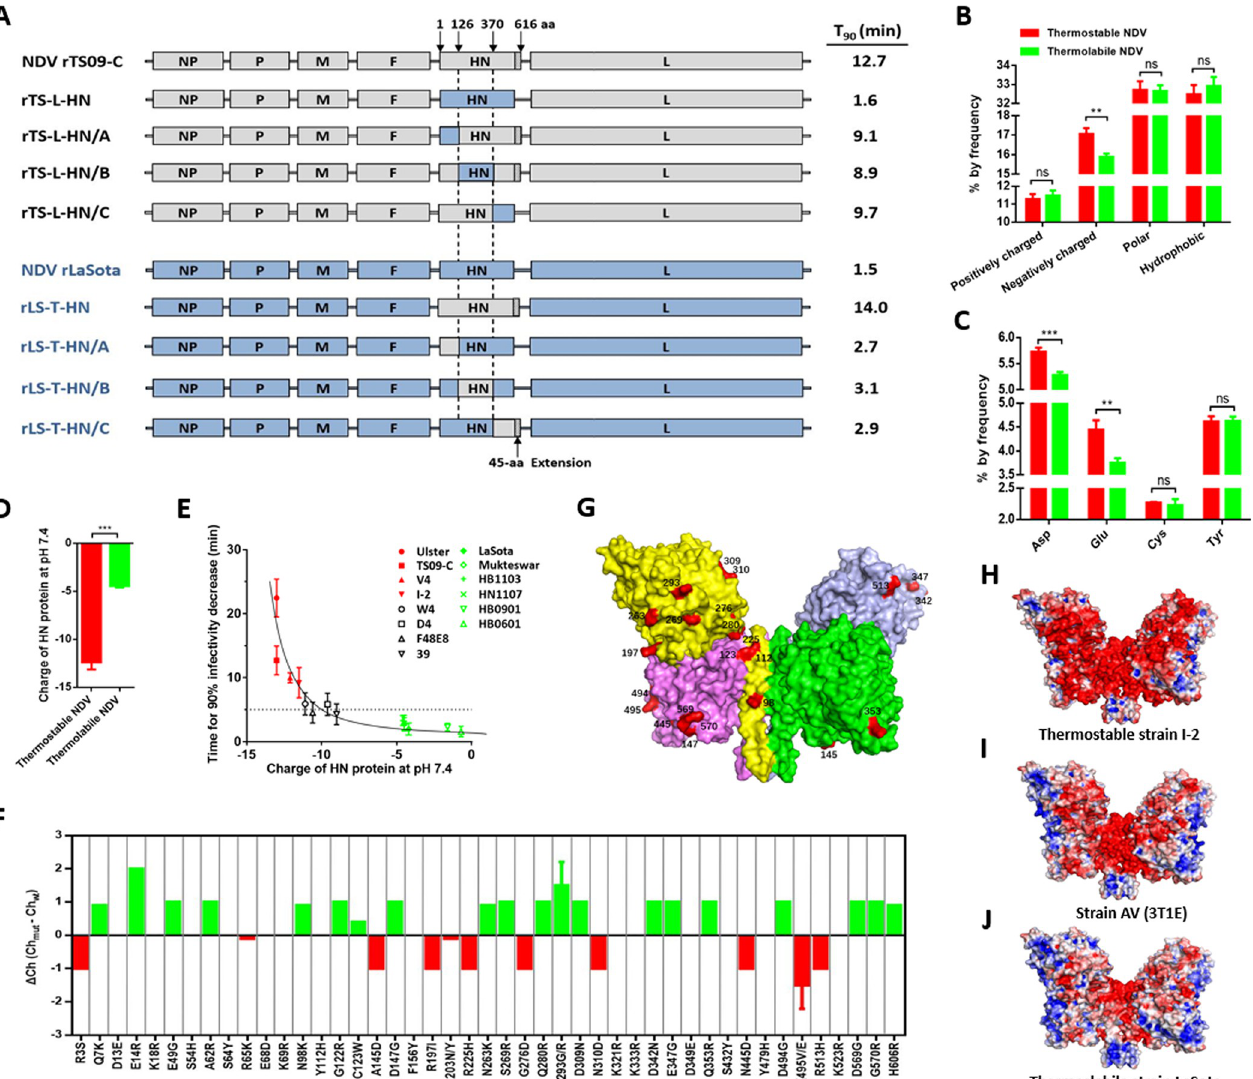
Fig 1. Charge of HN protein and its relationship with NDV thermostability. (A) Schematic representation showing the construction of chimeric NDVs. Grey and blue bars represent the genes of TS09-C and LaSota strain, respectively. Corresponding nucleotide numbers where the HN fragments are fused using In-fusion cloning technology are depicted. For each chimeric virus, the viral thermostability (Time for 90% infectivity loss, min) at 56˚C is indicated at right side of the diagram. (B) Percentage of amino acids with different characteristic in HN proteins from thermostable and thermolabile NDV strains. (C) Negatively charged amino acids composition of HN proteins from thermostable and thermolabile NDV strains. (D) Theoretical charge of HN proteins from thermostable and thermolabile NDV strains. The four thermostable strains are TS09-C, V4, I-2, and Ulster. The four thermolabile strains are LaSota, Mukteswar, HB1103, and HN1007. The theoretical charge of protein at pH 7.4 is determined by using IPC software (http://isoelectric.ovh.org), based on its amino acid sequence. (E) Scatter diagram showing the relationship between charge of HN protein and thermostability of NDV at 56˚C. Each point represents the data from one NDV isolate. (F) Effect of each charged amino acid substitution on the charge of HN protein of NDV strain TS09-C. (G) Mapping of charge- associated amino acid substitutions onto the surface of HN protein of NDV strain TS09-C. The 23 charge-associated amino acid substitutions are labeled on the protein surface and colored red. (H-J) Molecular surfaces of thermostable and thermolabile NDV HN proteins are colored according to electrostatic potentials with a range of red (- 5.0 V) to blue (+ 5.0 V). The structures of HN proteins from NDVs are obtained by homology modeling, using the HN structure of AV strain (PBD ID code 3T1E) as a